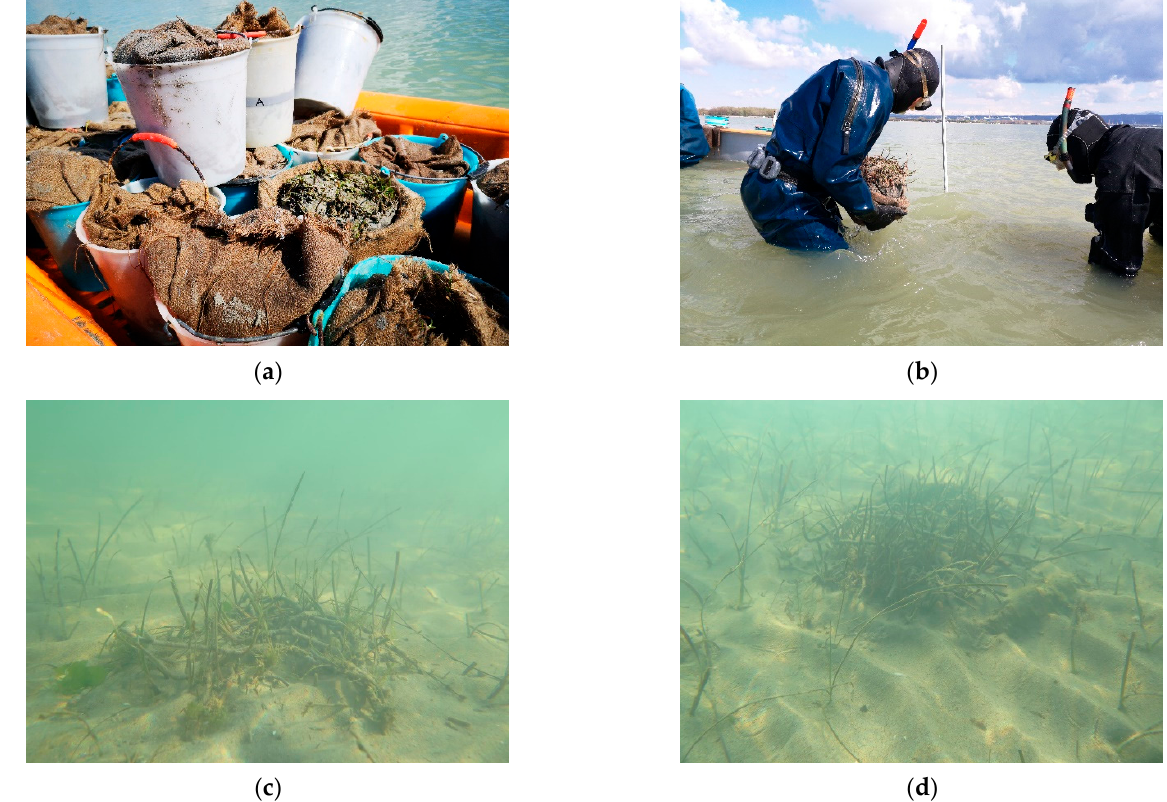
Figure 9. Panzano Bay (Gulf of Trieste) pilot transplantation by sods: ( a ) temporary storage of sods and their transport to the site to be reforested, ( b ) sods planting into the substrate by means of jute bags and ( c , d ) sods planted into the substrate.